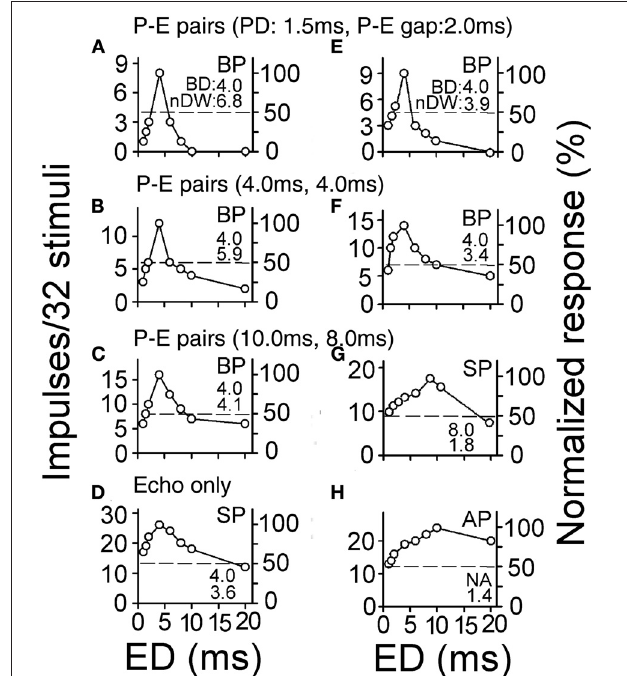
FIGURE 1 | (A) band-pass, (B) short-pass, (C) long-pass, and (D) all-pass duration tuning curves of collicular neurons of the FM bat, Eptesicus fuscus . Each horizontal dashed line indicates the 50% maximal response. The selectivity of each echo duration curve is expressed with a best duration (BD, indicated with an arrowhead) and a normalized duration width (nDW indicated with a double-arrowheads). NA: a BD is not available [Adapted from Wu and Jen (2006)].